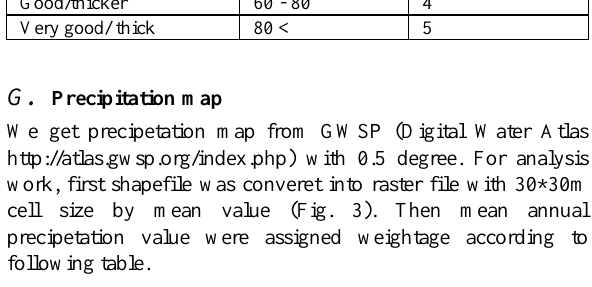
TABLE 5. Classification of annual precipetation.